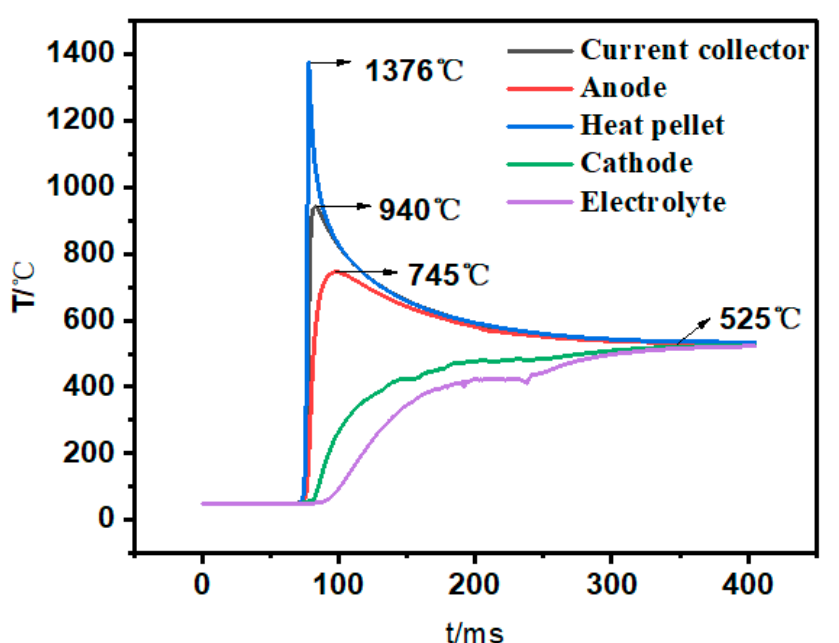
Figure 5. Temperature ‐ change diagram of thermal battery cells.